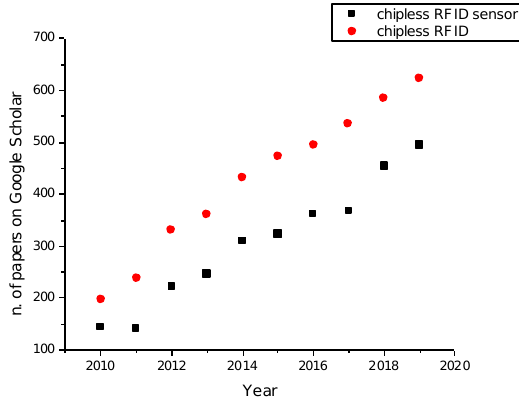
Figure 1. Number of entries per year on Google Scholar using the keywords “chipless RFID” (Radio-frequency identification) and “chipless RFID sensors” as for 24 February 2020.